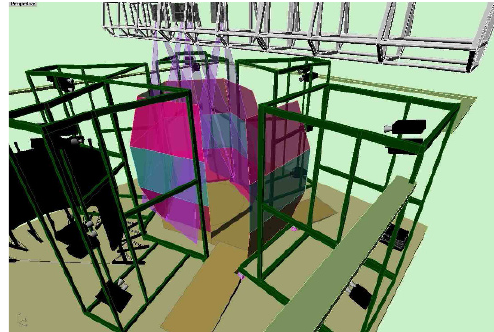
Figure 4. Calit2’s StarCAVE. Illustration: Greg Dawe.